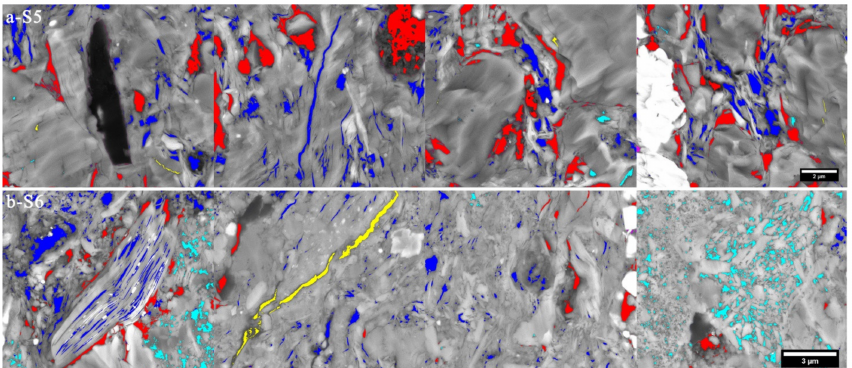
Figure 8. Pore identification in felsic shales: ( a ) S5; ( b ) S6. Red represents interparticle pores, blue represents intraparticle pores, cyan represents dissolution pores and yellow represents fracture.